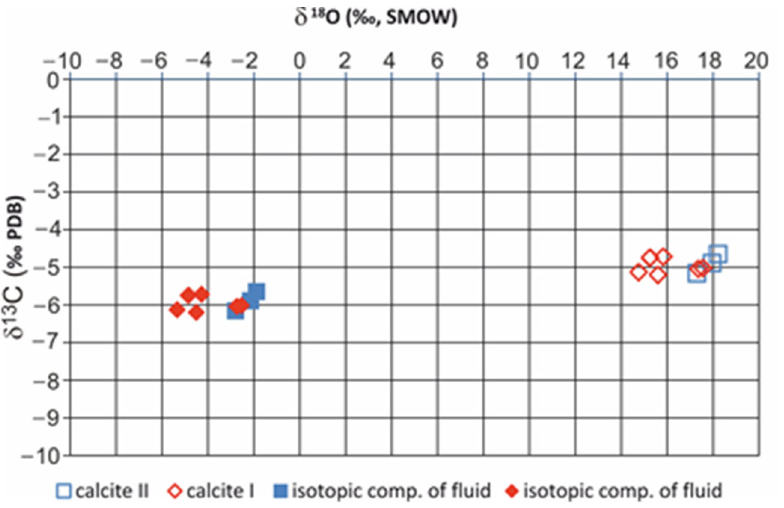
Figure 13. Isotopic composition of carbon and oxygen from calcite I and calcite II from the quartz– carbonate–sulfide vein. Explanations: empty symbols: measured data; filled symbols: isotopic composition of hydrothermal fluids.